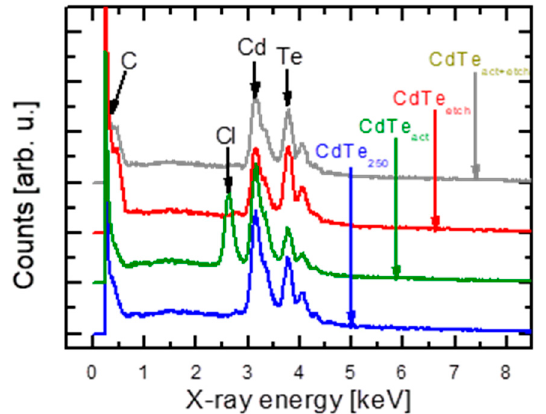
Figure 10. Energy-dispersive X-ray (EDX) spectroscopy data of CdTe 250 powders with differently treated surfaces. The surface treatments change the ratio of Cd to Te at the surface, represented by the relative heights of the peaks. “Activation” in CdCl 2 (green curve) leads to a deposition of Cl and lowers the Te concentration in relation to Cd. In contrast, “etching” (red curve) increases the Te concentration and lowers the Cd concentration. “activation plus etching” (grey curve) also leaves a (relatively) more Te-rich surface when compared to the original surface (blue curve). Clearly, for Te-rich surfaces, the elution of Te is increased (compare Figure 6b).